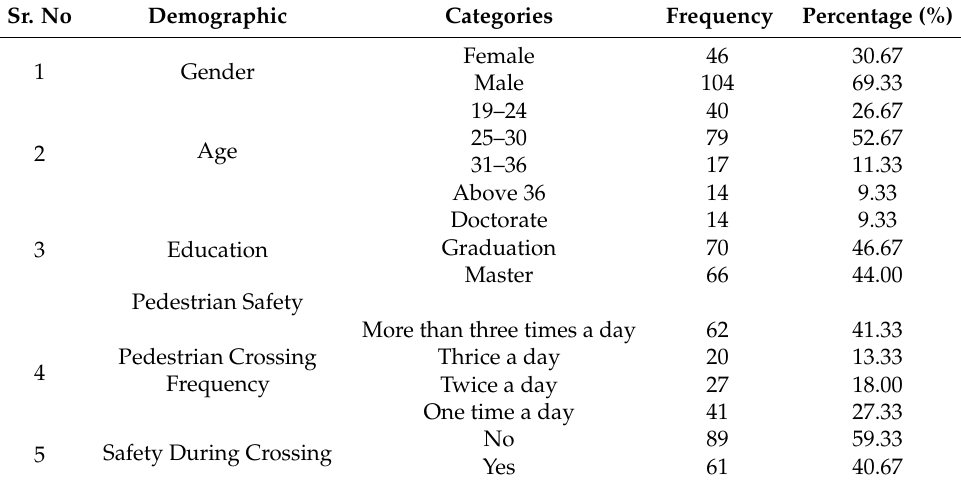
Table 1. Descriptive statistics of the